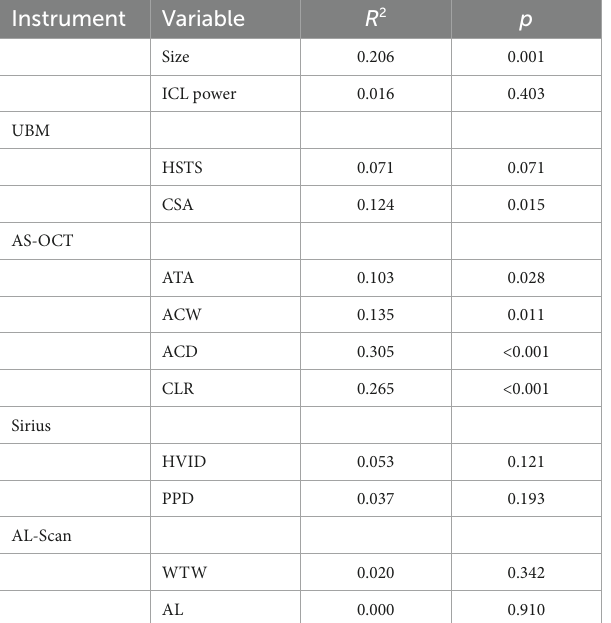
TABLE 2 Single regression analysis for determining WH formula in the training group. Instrument